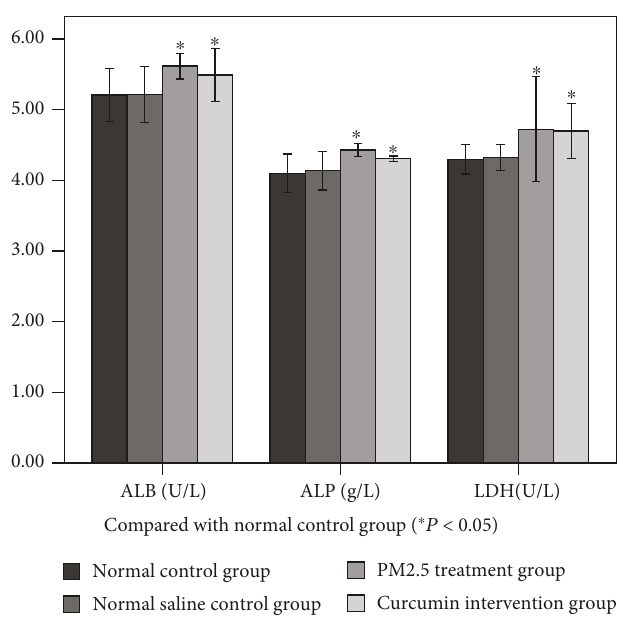
Figure 1: E ff ects of the PM2.5 on ALP, LDH, and ALB in bronchoalveolar lavage fl uid